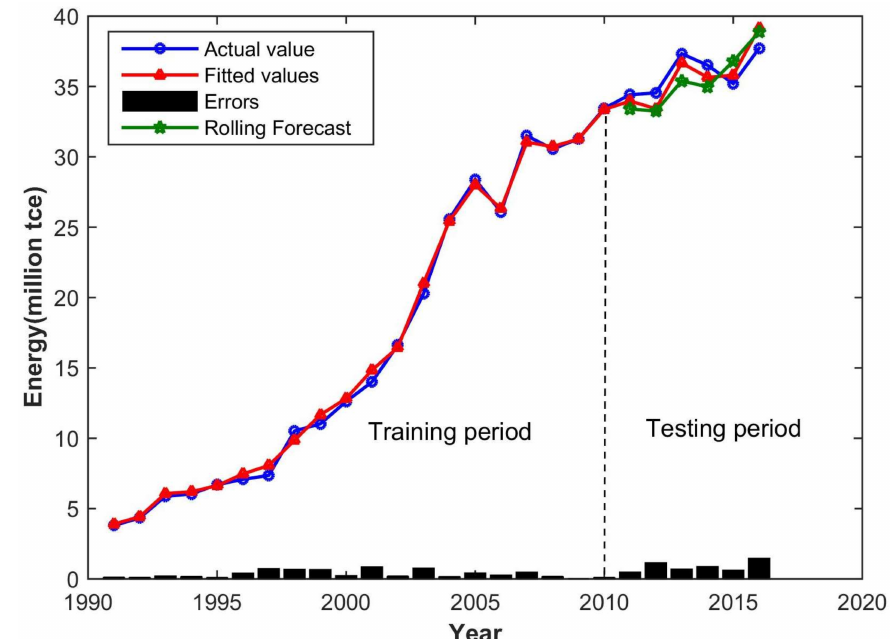
Figure 4. Results of energy demand in Wuxi by